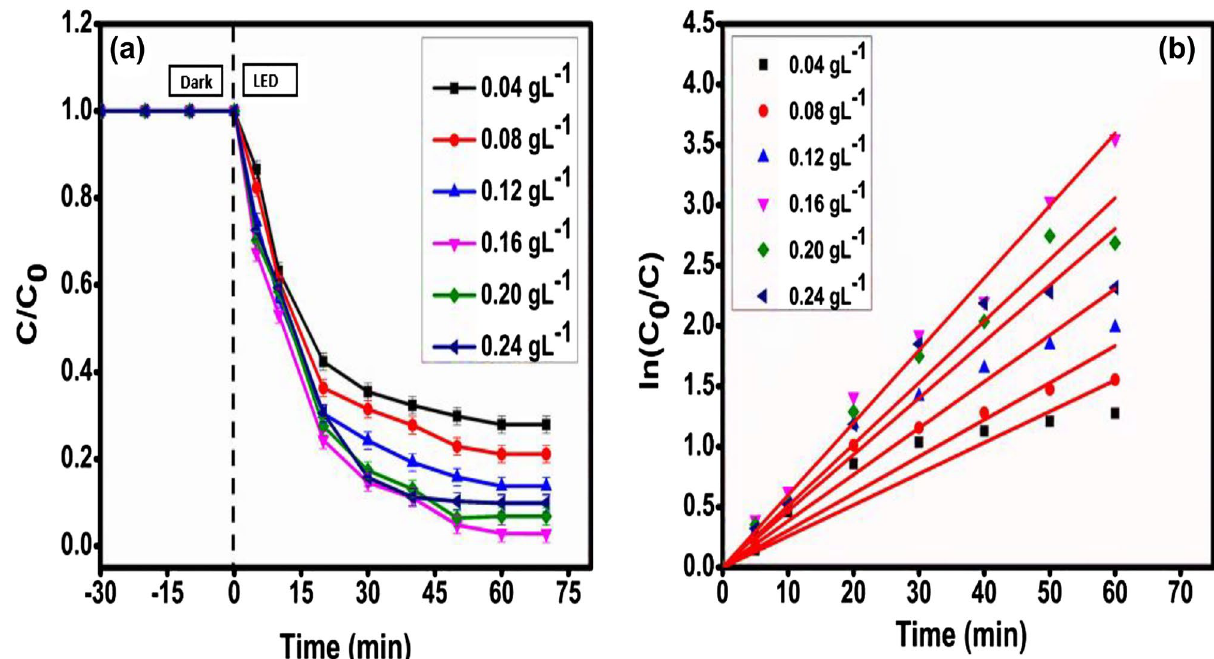
Figure 9. ( a ) Degradation profile and ( b ) kinetics plot for CMCu photocatalyst dose optimization.